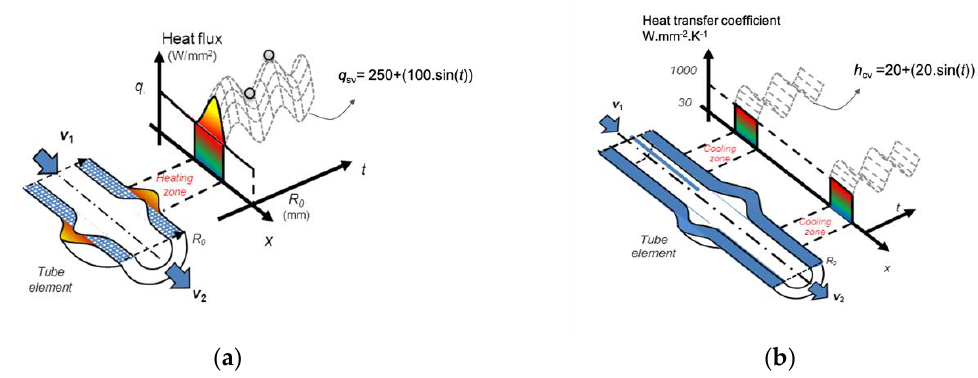
Figure 4. ( a ) Schematic of a variety of heating ( q s ) and ( b ) a variety of cooling system ( h c